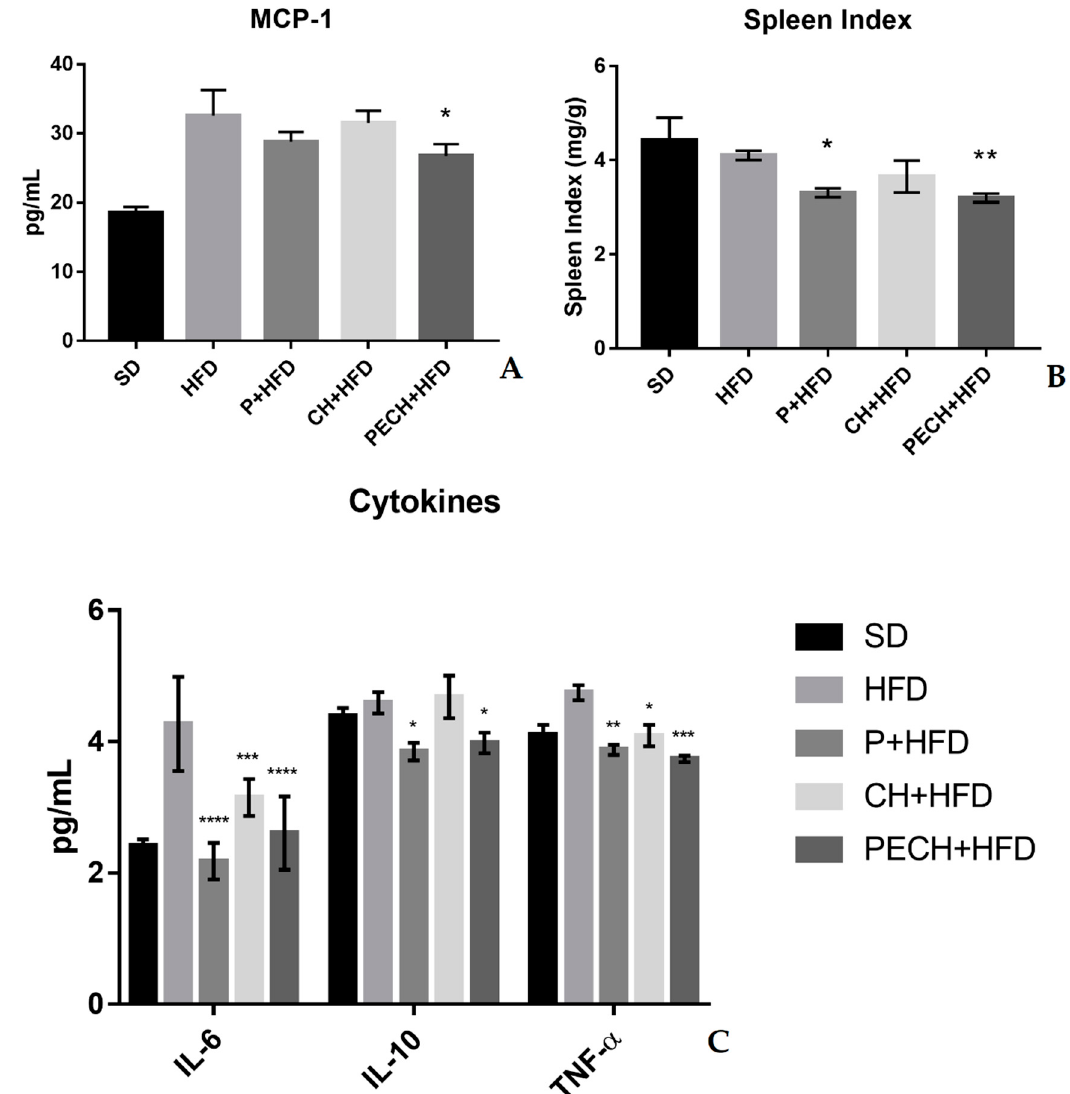
Figure 4. Effect of different diets on inflammatory biomarkers. ( A ) MCP-1 levels, ( B ) spleen index, ( C ) citokine levels (IL-6, IL-10, TNF- α ). The different diets compared were standard diet (SD, n = 4), high-fat diet (HFD, n = 8), phenolic-enriched high-fat diet (P + HFD, n = 8), lyophilized cooked ham enriched high-fat diet (CH + HFD, n = 8) and lyophilized phenolic enriched cooked ham enriched high-fat diet (PECH + HFD, n = 8). HFD mean results were compared against P + HFD, CH + HFD and PECH + HFD diets, significant differences are expressed as * p < 0.05 ** p < 0.01 *** p < 0.001 **** p < 0.0001.